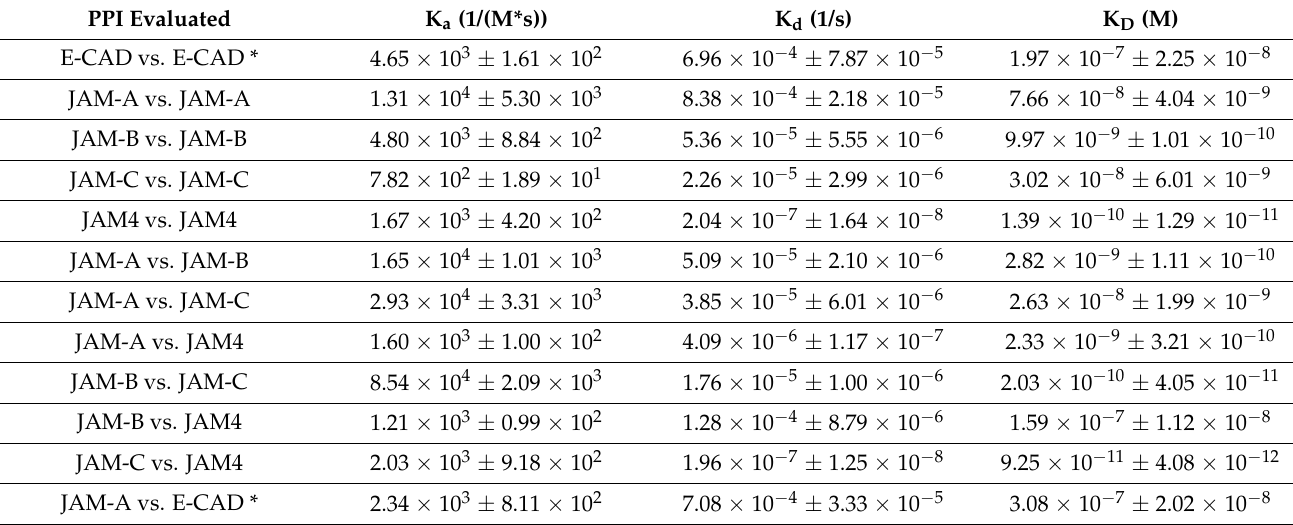
Table 1. Surface Plasmon Resonance analysis. Protein–protein interactions were analyzed using SPR (see Materials and Methods). The data were analyzed with TraceDraw software. Here, we present values for constant of association, Ka (1/(M*s)); constant of dissociation, Kd (1/s); and constant of affinity, KD (M). Standard deviations are reported. * E-CAD experiments conducted in the presence of 3 mM